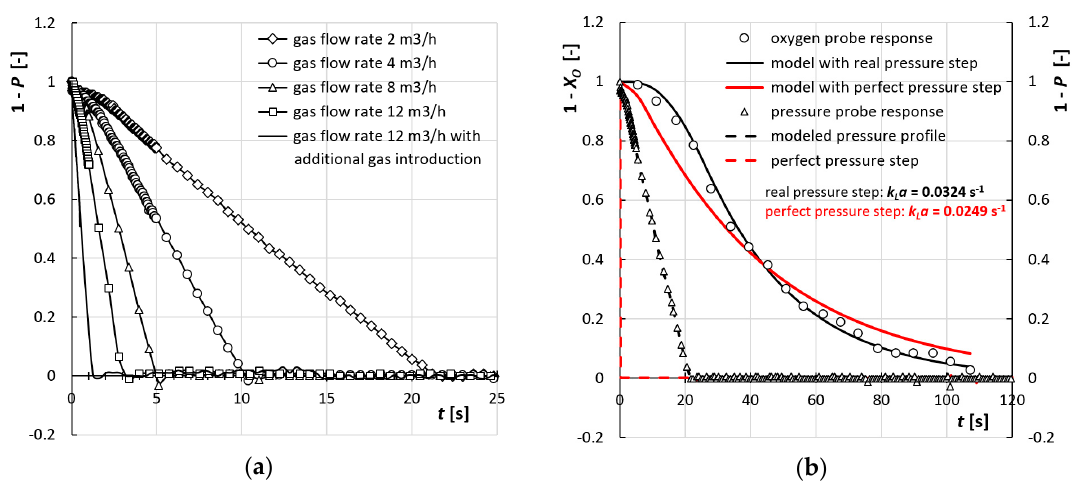
Figure 4. Examples of ideal and non-ideal pressure profiles: ( a ) examples of real pressure profiles and ( b ) comparison of modeled O 2 concentration profiles and final k L a values for real pressure step (black lines) and for assumption of perfect pressure step (red lines). Water-air system, Q G = 2 m 3 /h.